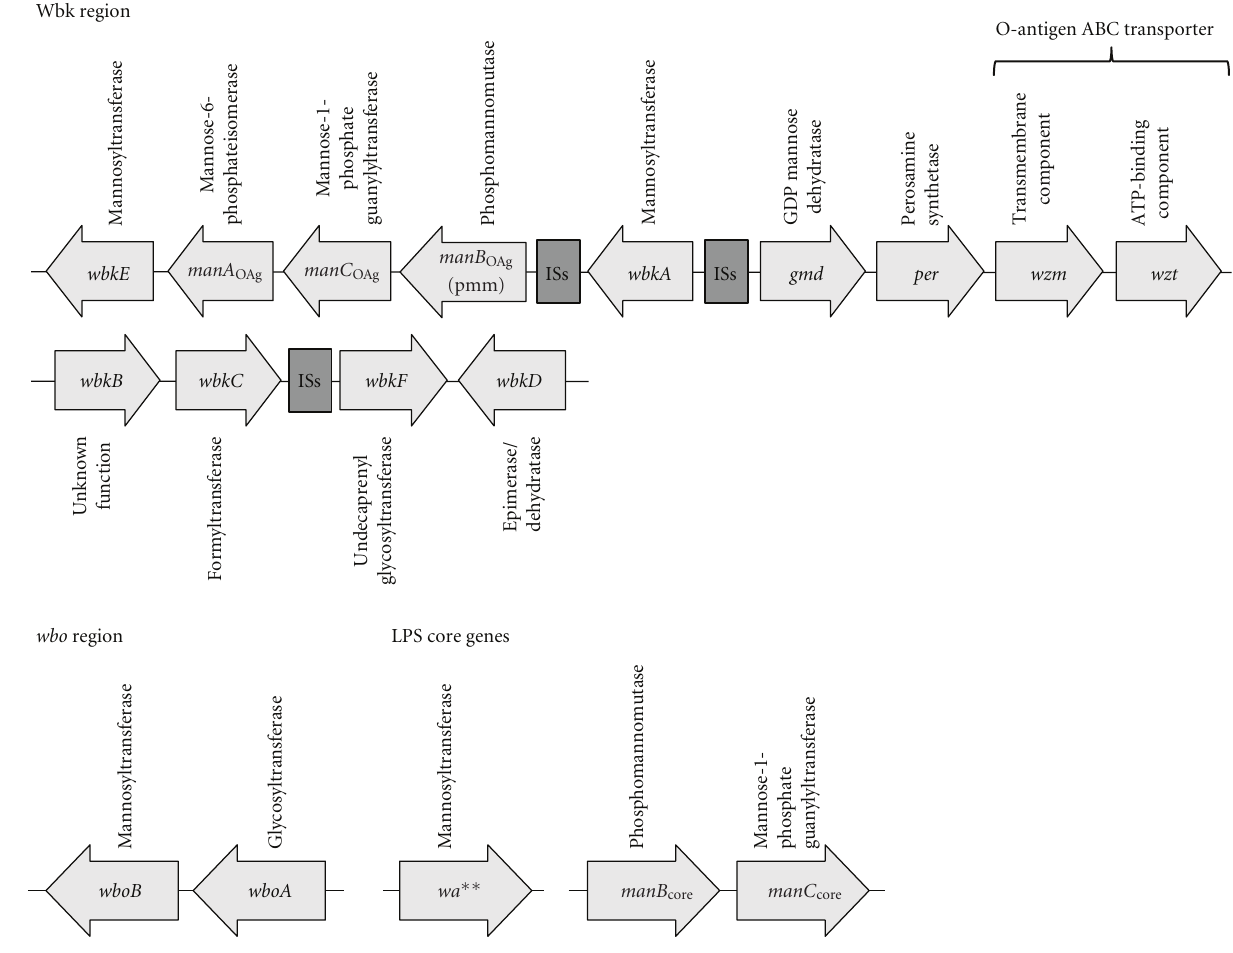
Figure 3: Genomic organization of O-antigen and core biosynthesis genes. The genes predicted to be involved in the biosynthesis of B. melitensis LPS O-antigen and core molecule are distributed at four di ff erent loci throughout the genome. The majority of the genes are located in the wbk region and the wbo region on chromosome I. Genes involved in the core biosynthesis can be found on chromosome I ( wa ∗∗ ) and chromosome II ( manB core and manC core ). The wbk region contains multiple insertion sequences (ISs) suggesting that this region was acquired through horizontal gene transfer